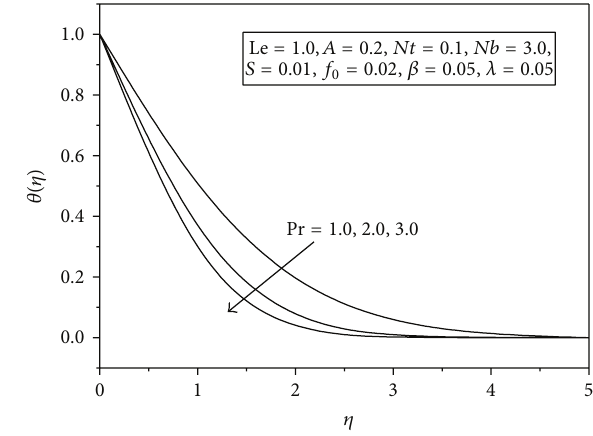
Figure 12: Concentration profile for different values of 𝑁𝑡 .